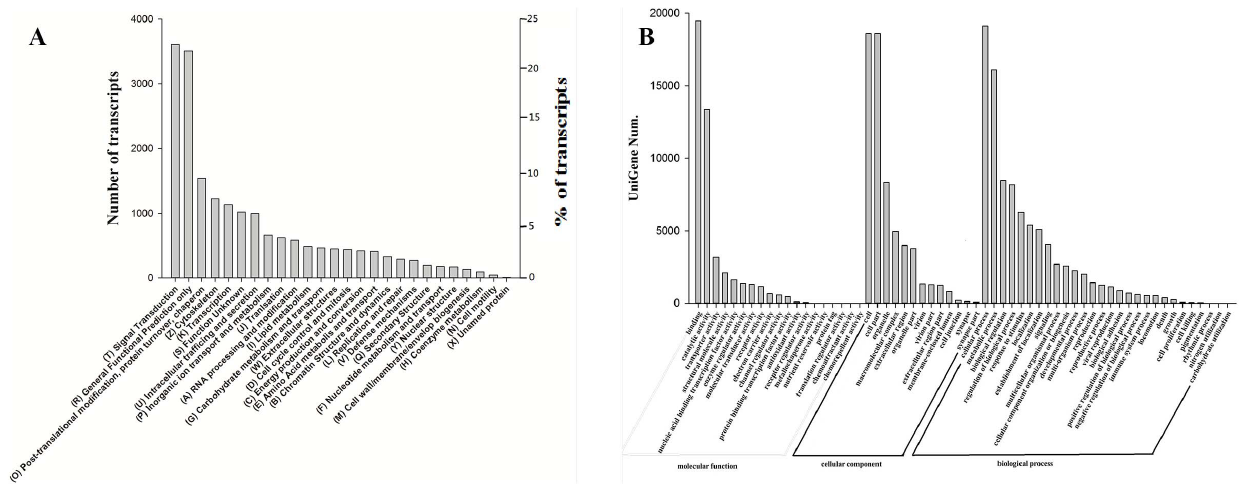
Figure 2. Functional annotations of the unigenes of C.idella . (A) KOG annotation. (B) Level 2 GO term distribution for the biological process, cellular component and molecular function categories.